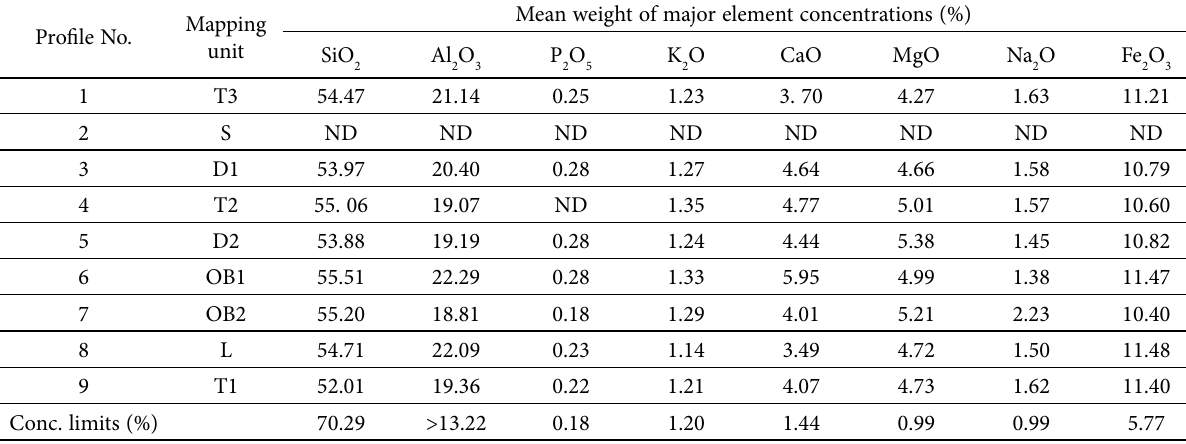
Table 8. Mean weight of major oxide concentrations in soil samples and representative average limits (Bohn et al. 2001) Profile No.